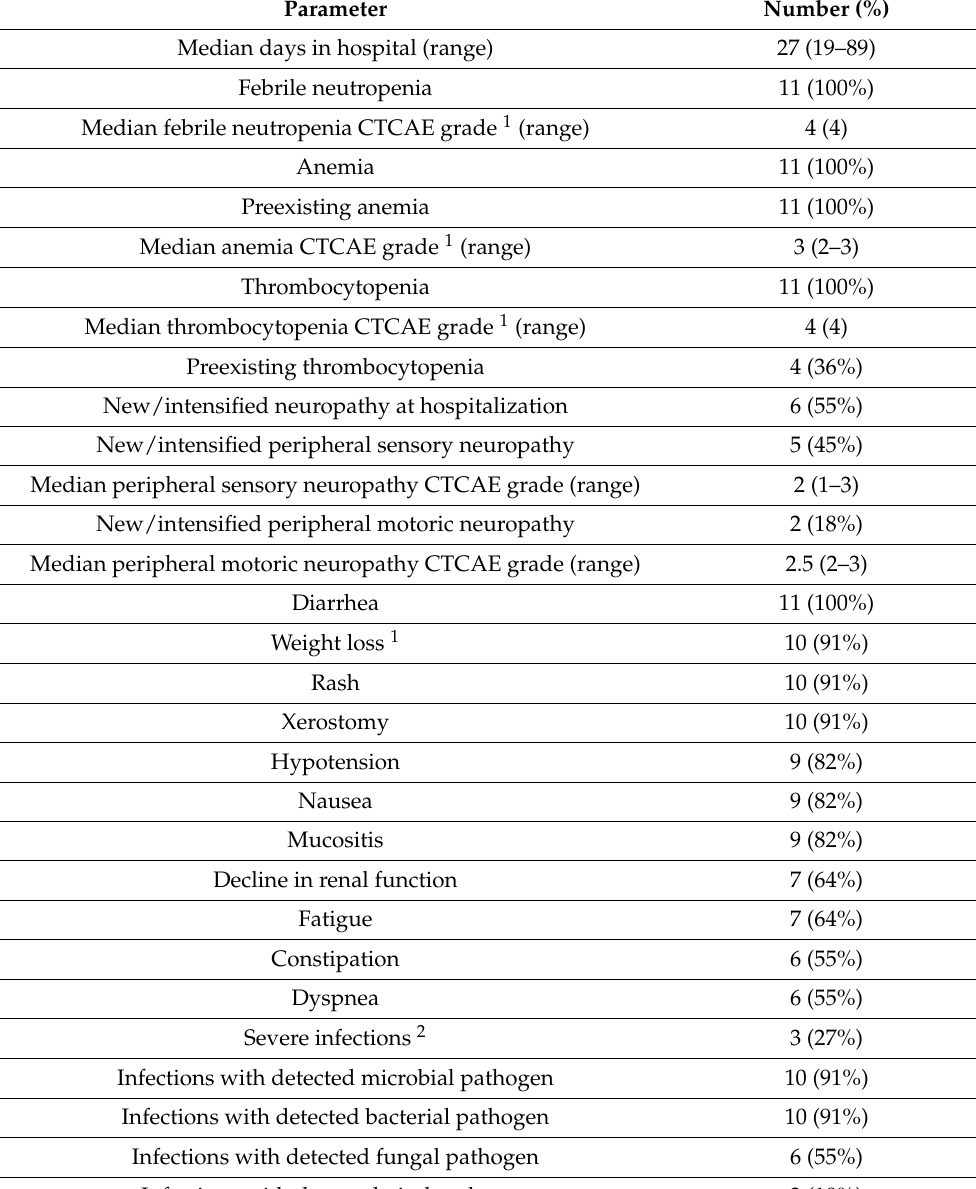
Table 3. Hematologic and non-hematologic toxicities and infections following